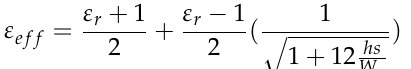
Figure 3. Proposed antenna design steps: ( a ) simple rectangular patch (ANT I), ( b ) patch with L-shape slots in the upper side (ANT II), ( c ) proposed patch (ANT III).